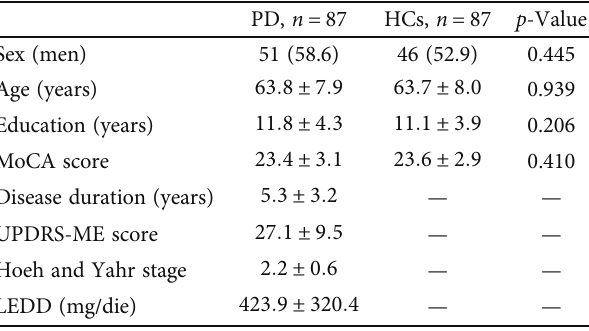
Table 1: Demographic and clinical